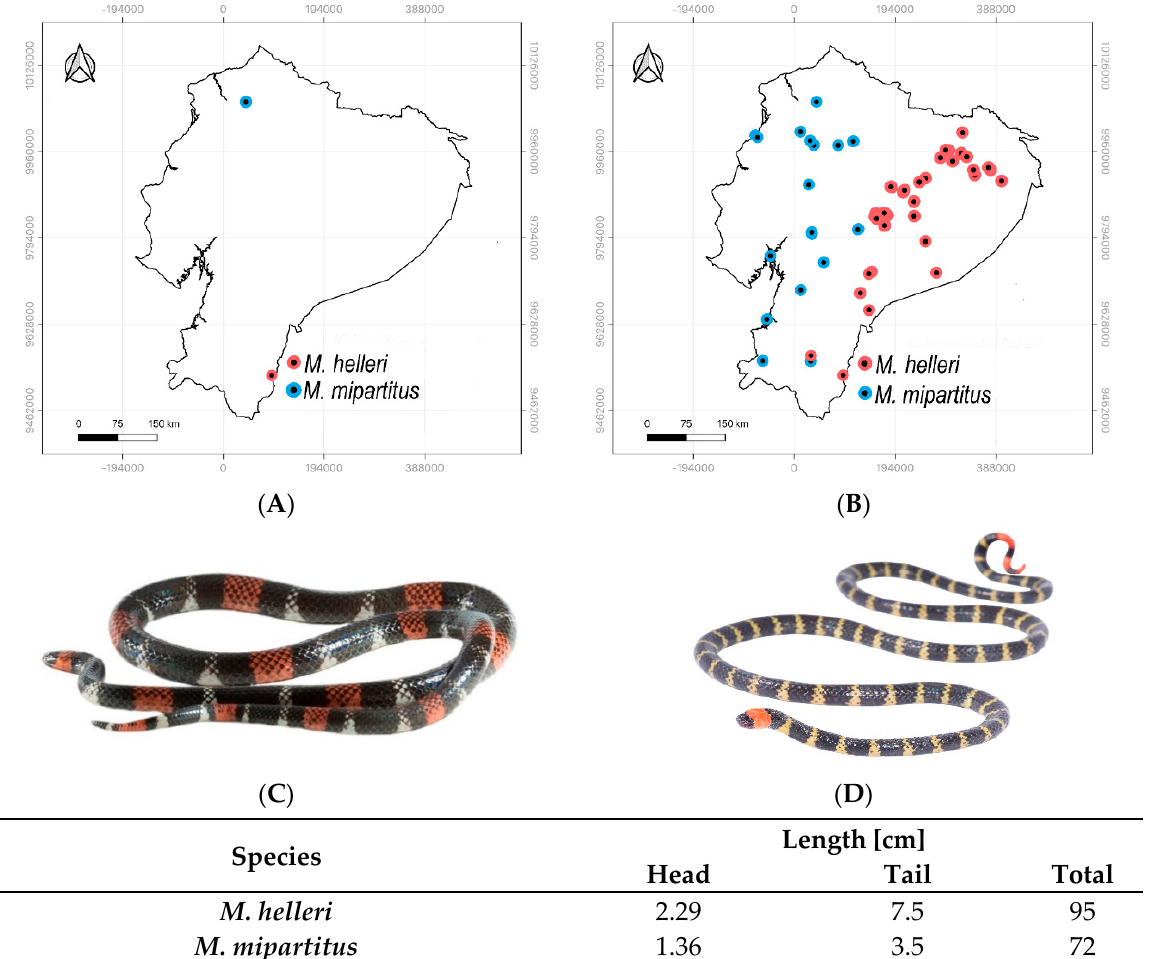
Figure 2. Venom collection and species occurrences of Ecuadorian coral snakes. ( A ) Sample from M. helleri (red) was extracted from a specimen found in Nangaritza (Zamora Chinchipe), while venom from M. mipartitus (blue) was obtained from a snake found in Quinindé, Jevon Forest Biological Station (Esmeraldas). ( B ) Spatial distribution of these two Micrurus species in Ecuador. This map was constructed using geospatial data from (GBIF, http://www.gbif.org) and VertNet (http://www.vertnet.org). Both biodiversity-related repositories were accessed on 18 September 2022. ( C ) M. helleri (photo by María José Quiroz; reproduced here from https://bioweb.bio, accessed on 1 November 2022, under a CC BY-NC-ND 4.0 License) and ( D ) M. mipartitus specimens (photo by Diego R. Quirola).